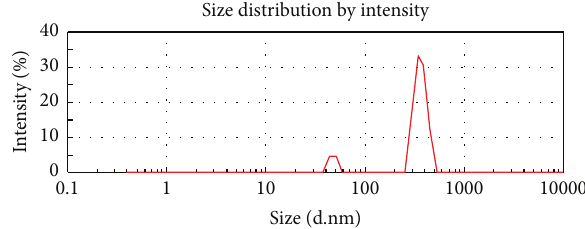
Figure 9: Particle size distribution for TFT-LCD secondary effluent.